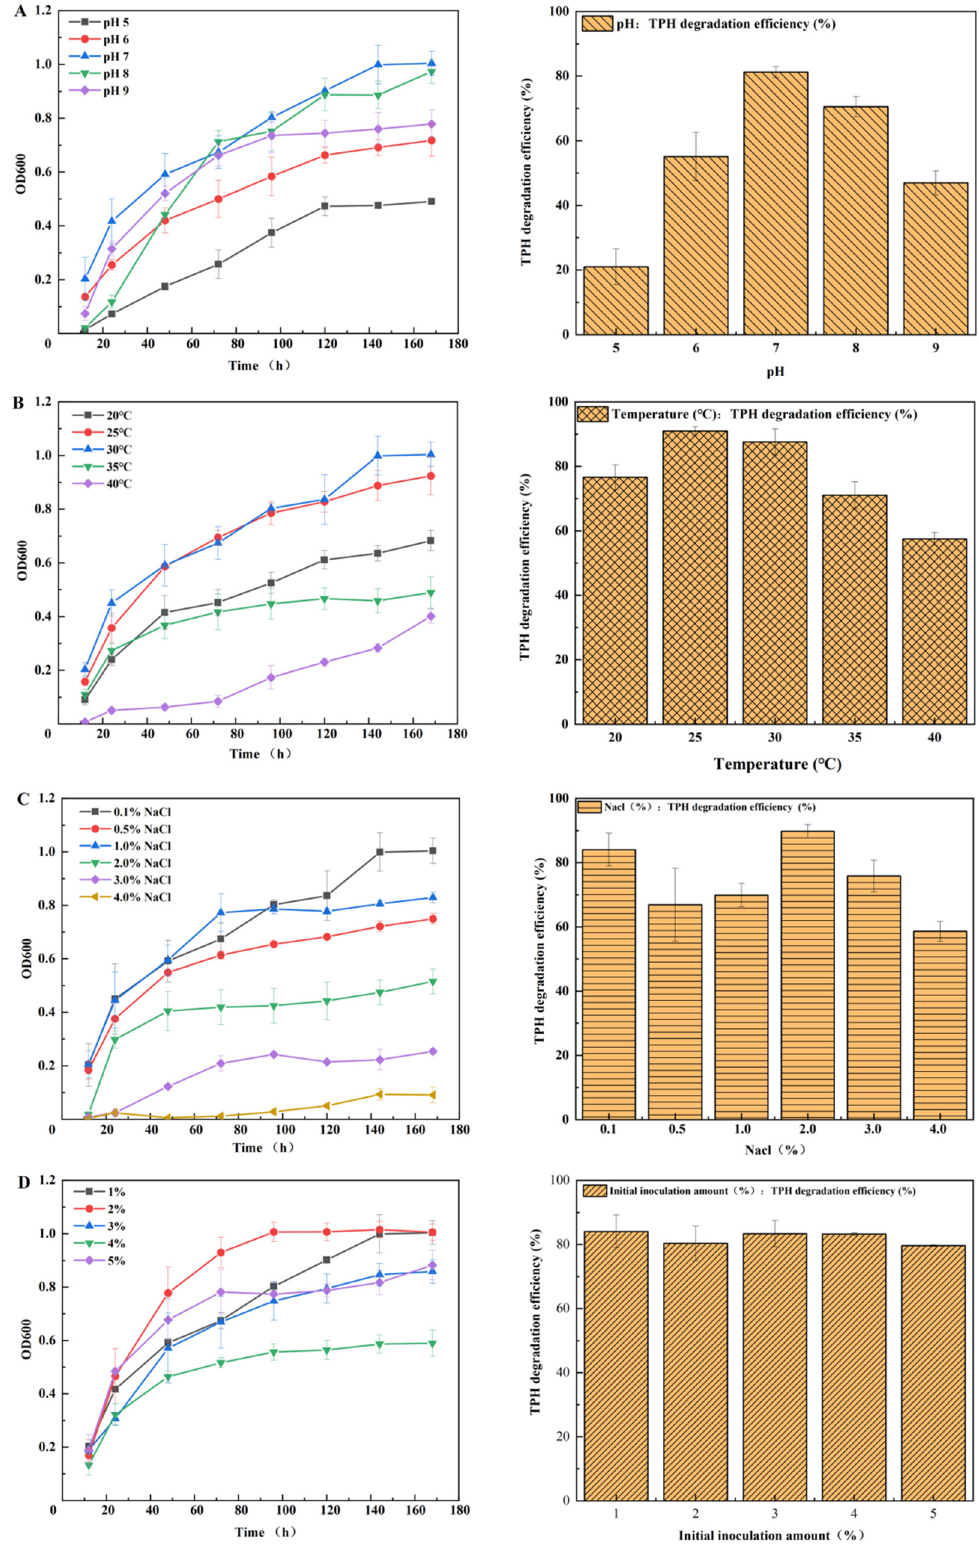
Figure 3. Effect of environmental factors on diesel oil removal by strain JYZ-03. ( A ) pH; ( B ) incubation temperature; ( C ) NaCl concentration (%); ( D ) inoculum concentration. The experiments of “TPH degradation efficiency” were performed in MSM medium, and the experiments of the “Turbidity” (OD 600 ) were performed in LB medium.